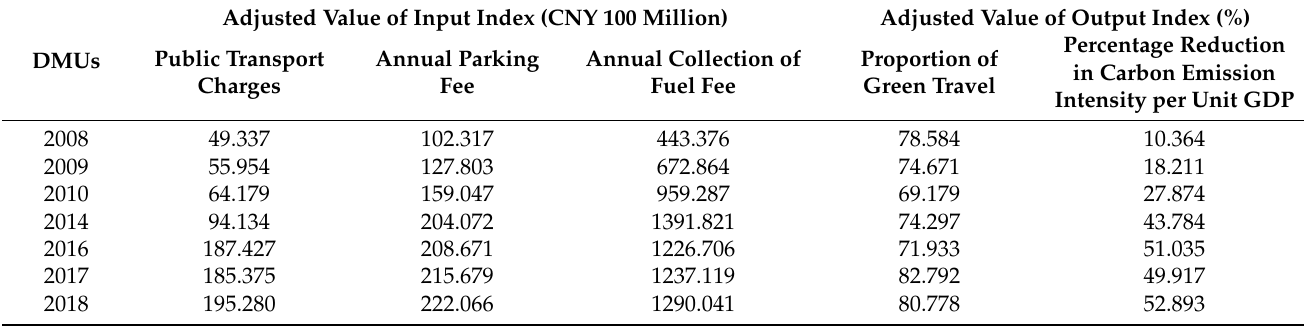
Table 5. Adjustment values for the input and output indexes of non-DEA effective